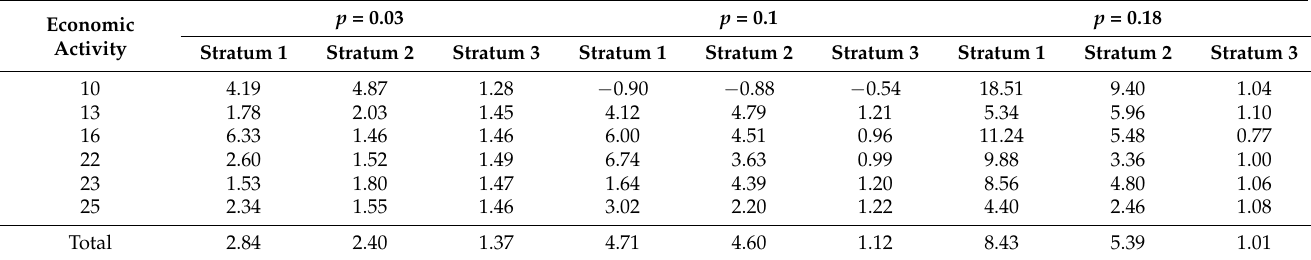
(cid:16) ˆˆ (cid:17) t yh for estimators of totals in the strata.